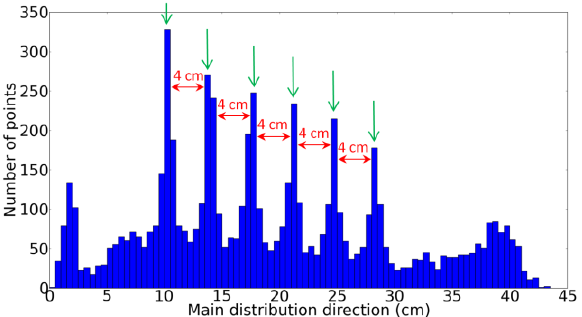
Figure 8. Histogram of a segment containing an insulator